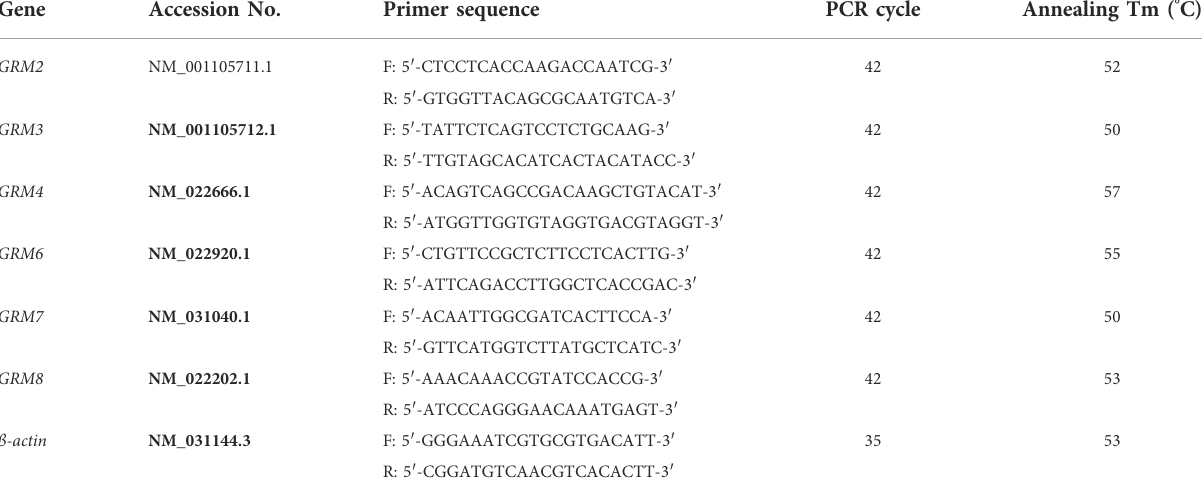
TABLE 2 Sequence of rat primers used in RT-PCR